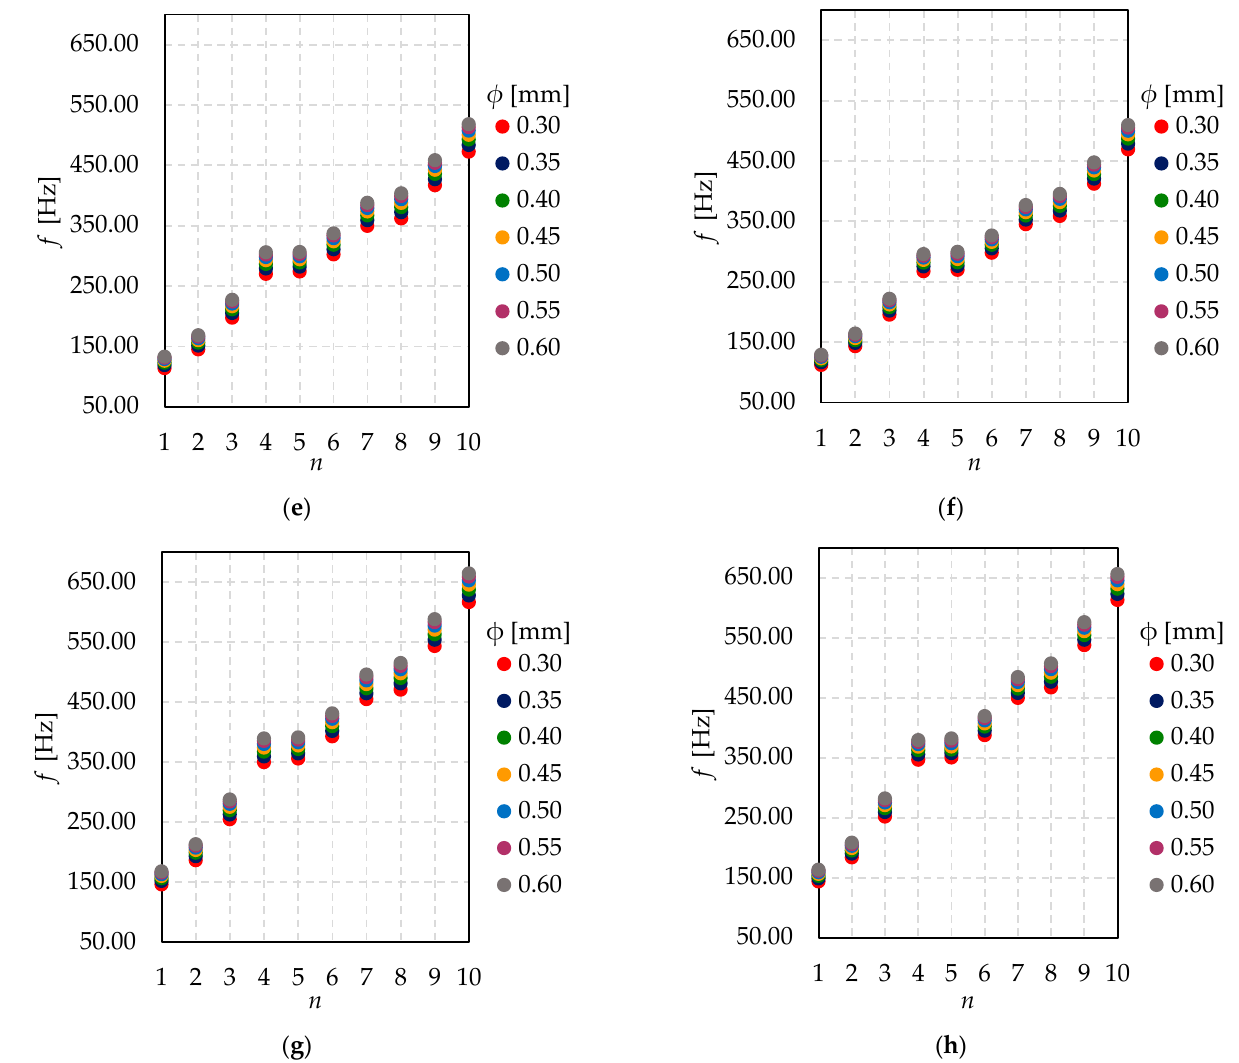
Figure 14. The relationship between natural frequency ( f ) and mode shape number ( n ) for different pillar diameter ( ϕ )—( a ) h = 4 mm and x 0 = y 0 = 50 mm; ( b ) h = 4 mm and x 0 = y 0 = 100 mm; ( c ) h = 5 mm and x 0 = y 0 = 50 mm; ( d ) h = 5 mm and x 0 = y 0 = 100 mm; ( e ) h = 6 mm and x 0 = y 0 = 50 mm; ( f ) h = 6 mm and x 0 = y 0 = 100 mm; ( g ) h = 8 mm and x 0 = y 0 = 50 mm; ( h ) h = 8 mm and x 0 = y 0 = 100 mm.